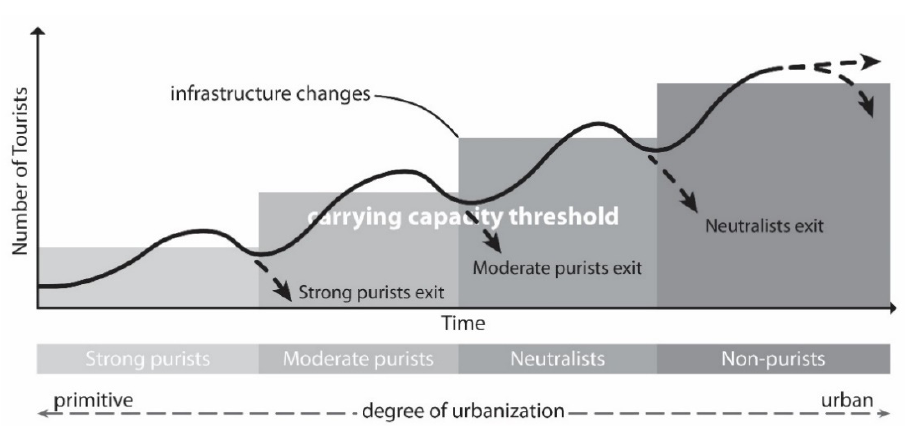
Figure 3. Adaptation of TALC considering Haraldsson and Ólafsdóttir’s Purity Scale. Graphic by author, adapted from Haraldsson & Ólafsdóttir, 2018.